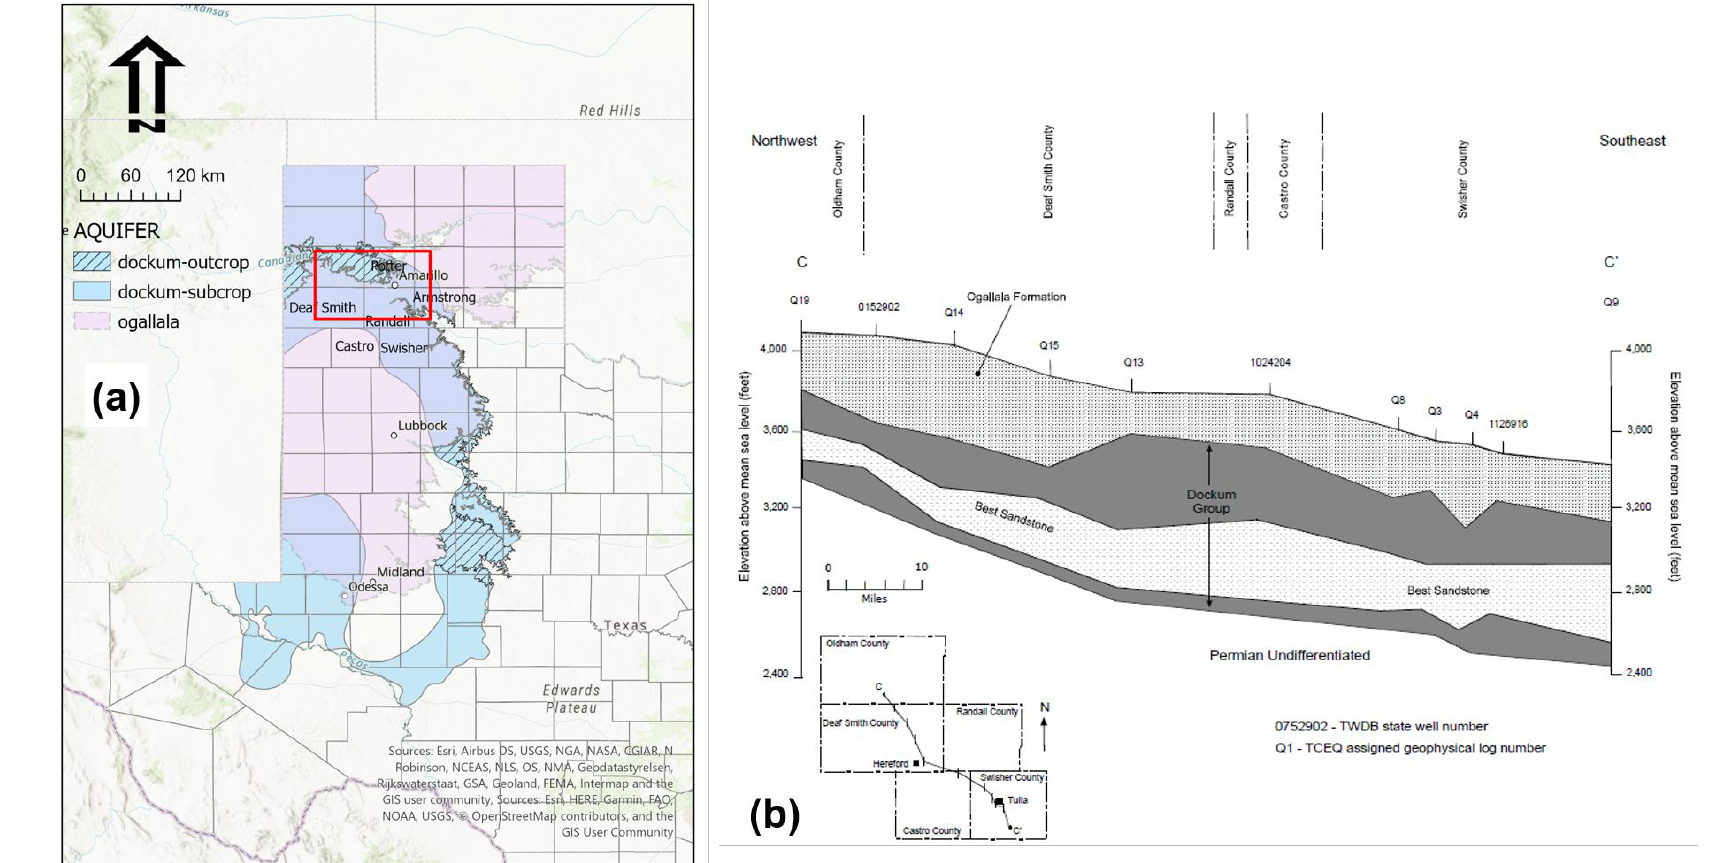
Figure 3. Dockum aquifer in context with the Ogallala aquifer within the state of Texas and with county boundaries indicated. ( a ) The focus region for the current study shown in the red bounded rectangle. Aquifer boundary shown is the downdip section which has TDS <5000 mg/L as determined by Ashworth and Hopkins [42]. ( b ) Representative geologic cross-section for Ogallala and Dockum group sediments in four counties (NE to SW: Oldham, Death Smith, Randall, Swisher) which cover a large section of the study area as indicated in the county inset map. Geologic cross-section taken from Bradley and Kalaswad [34].